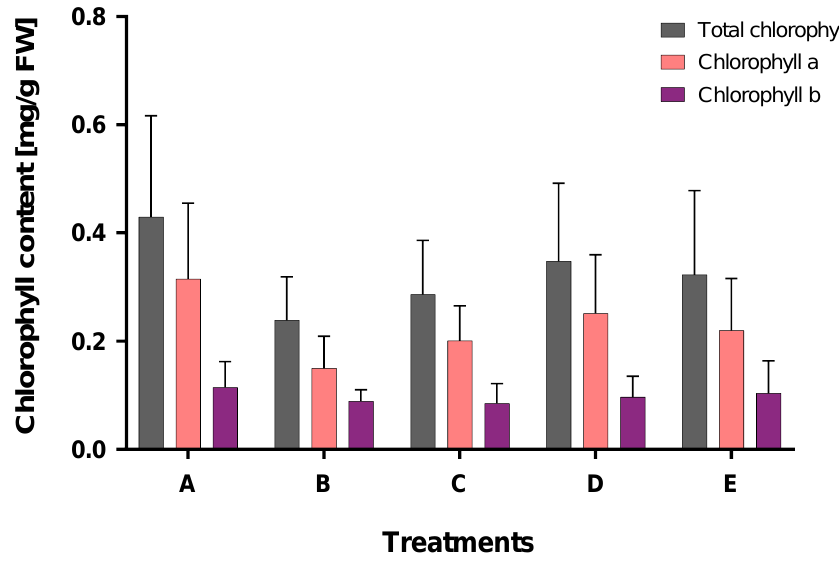
Figure 3. Chlorophyll (a, b, total) content in plant tissues (leaves) for all treatments at the end of the experiment.